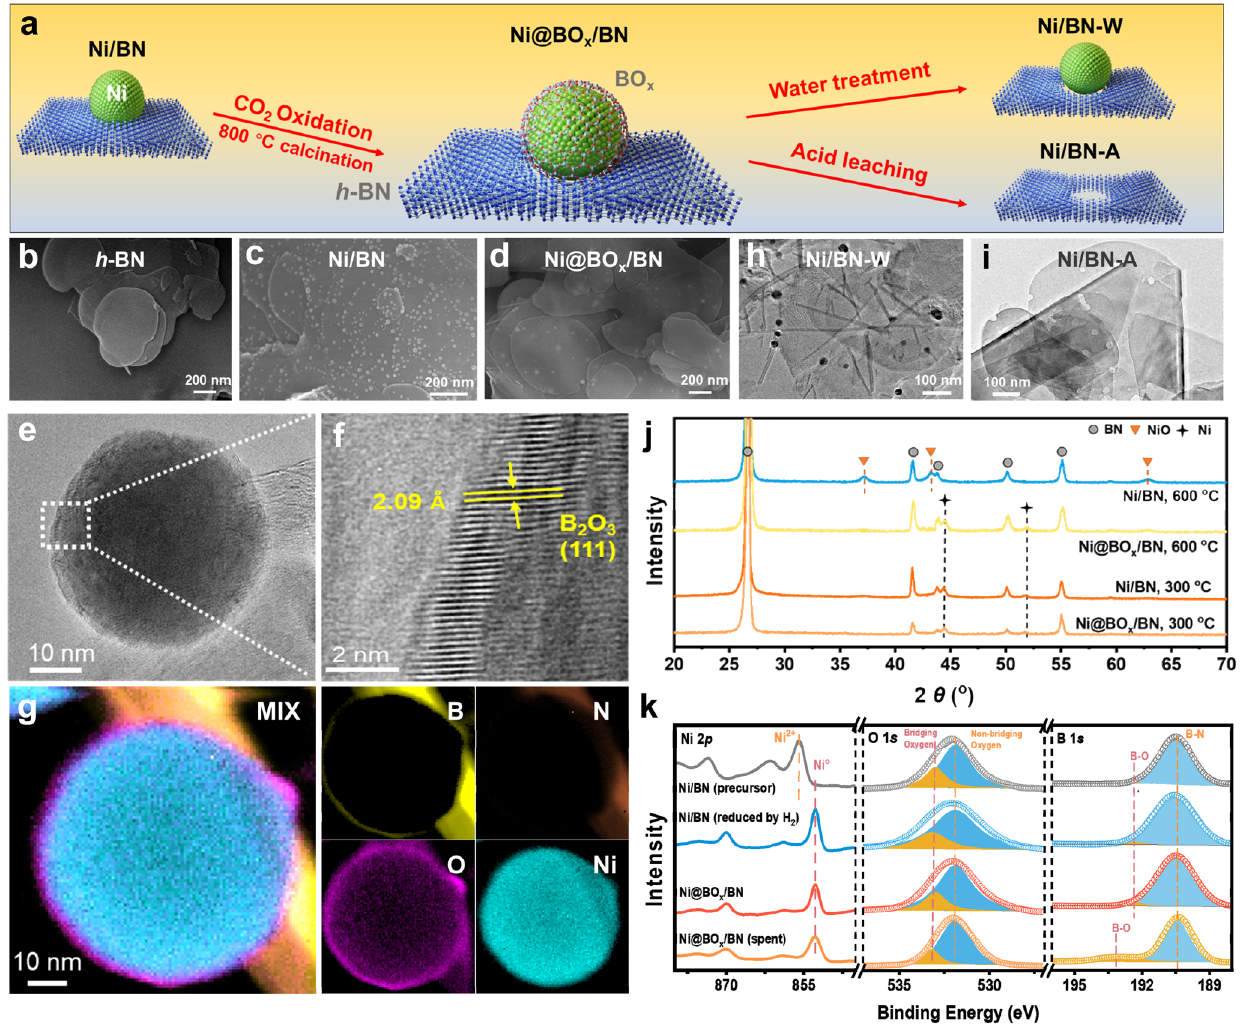
Fig. 1 | Structural characterization of the Ni-BN composites. a A schematic illustration of the synthesis procedure of Ni-BN composites. b – d electron micro- scopyimagesofh-BN,Ni/BNand Ni@BO x /BN. e , f High-resolutionTEMimagesofa representative Ni@BO x particle and the core-shell interface of Ni@BO x /BN. g EELS